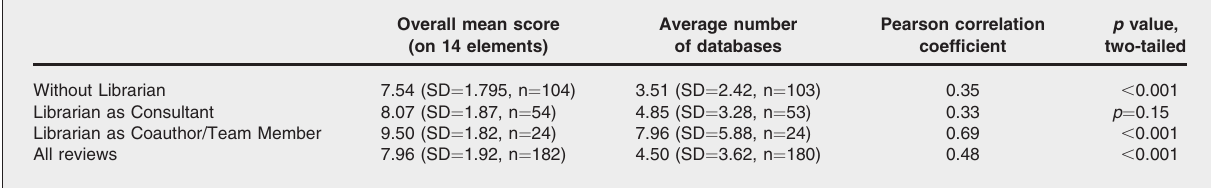
Reporting scores based to the average number of databases used for data collection in each